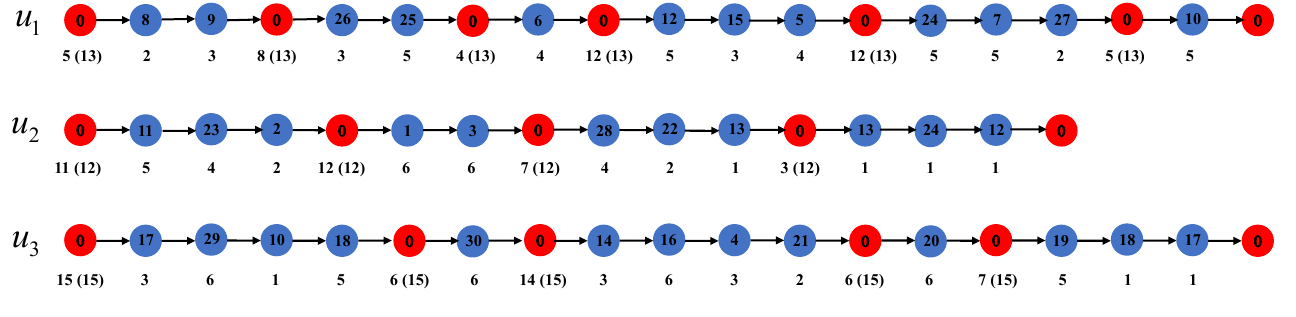
Figure 5. Solution of the instance